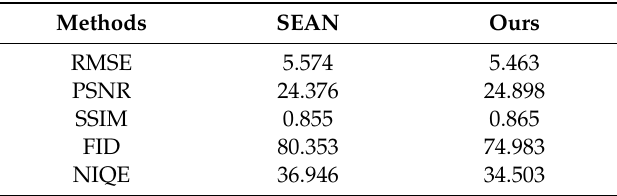
Table 1. Quantitative